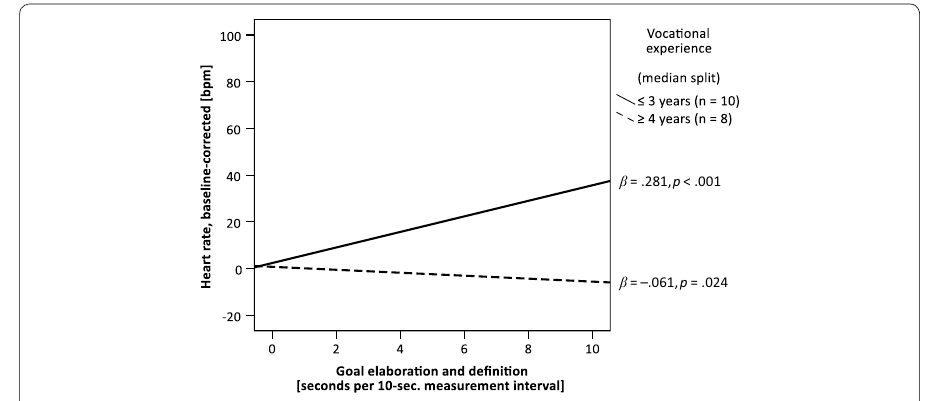
Fig. 3 Interaction effect: vocational experience